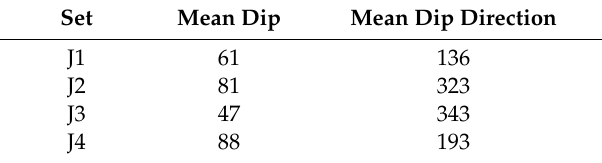
Figure 5. Examples of the main discontinuity sets identified on the mid-part of the rock slope. 4.2.2. Kinematic Stability Analysis